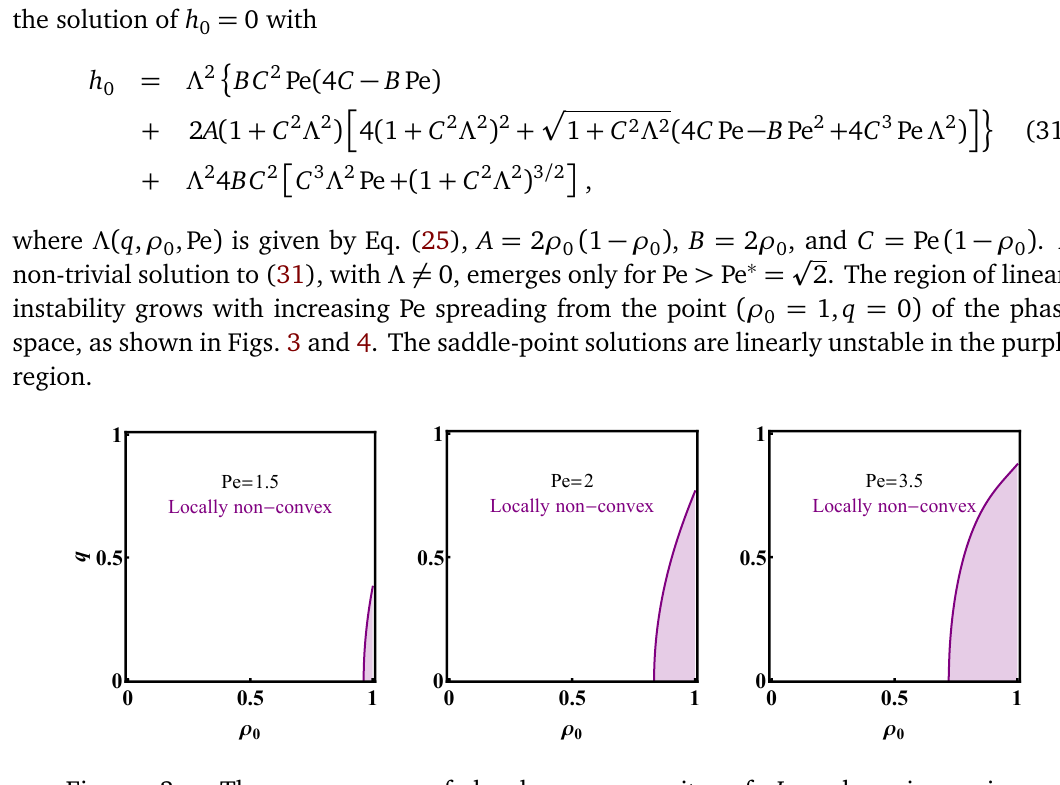
when increasing H